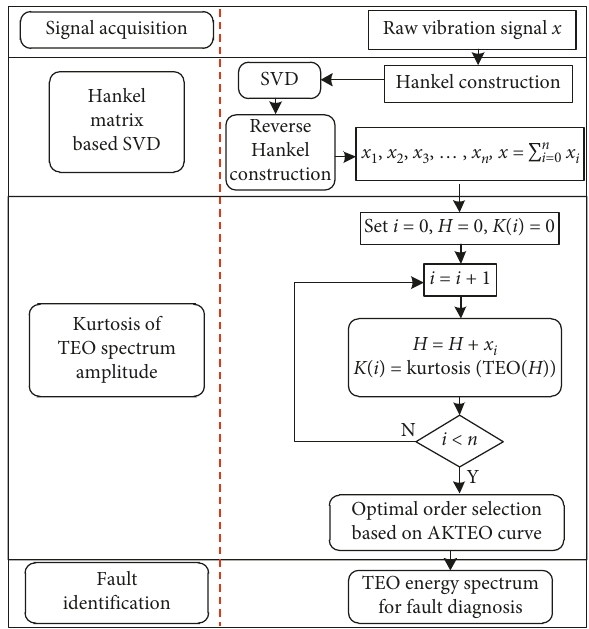
Figure 4: The framework of SVD-KTEO. Table 1: Parameter for REB fault signal simulation with outer raceway defect.